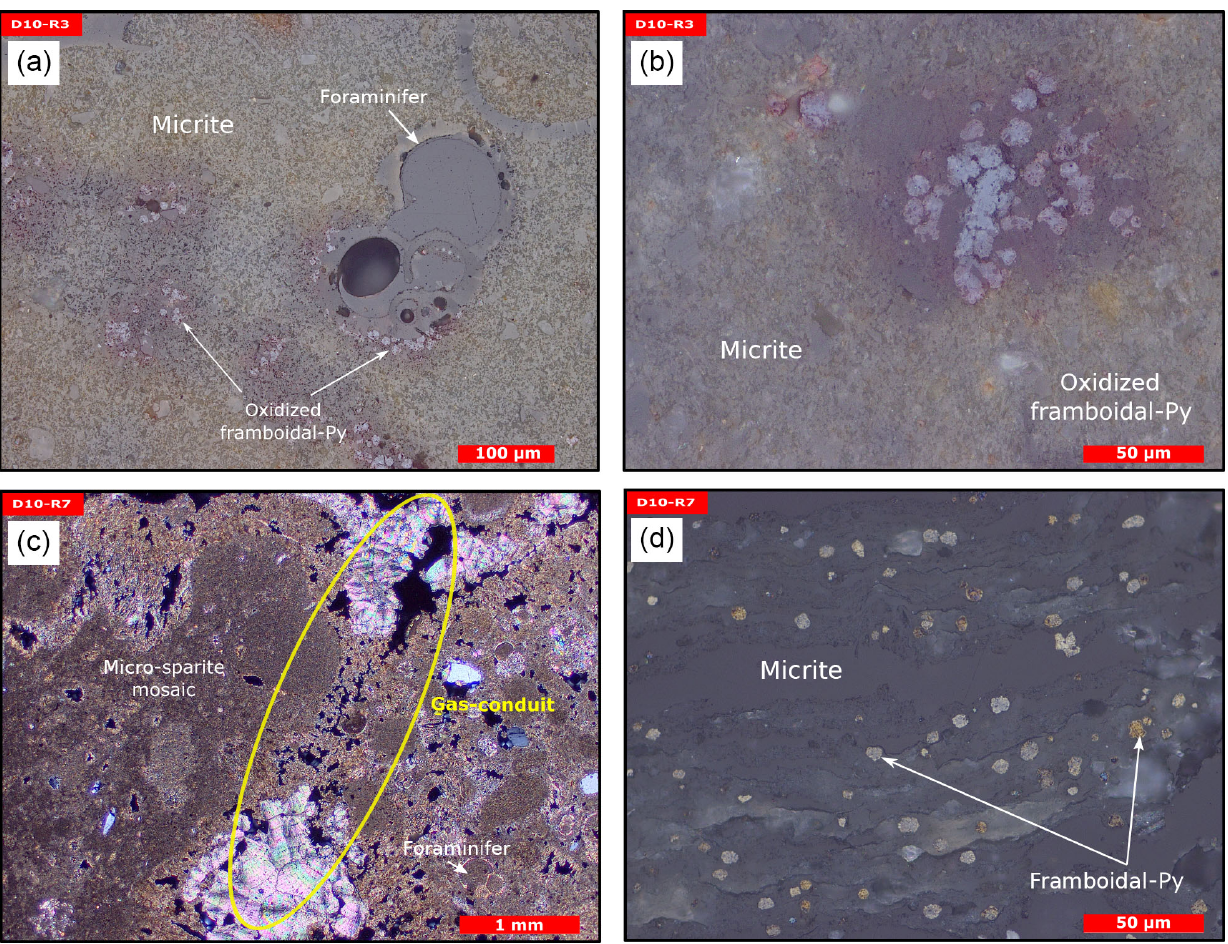
Figure 8. Thin section photographs of MDACs. (a–b) D10-R3 consisting of a micritic matrix with scattered foraminifers and oxidized framboidal pyrites (reflected light). (c–d) D10-R7 consisting of micritic and micro-sparitic carbonate with abundant unaltered framboidal pyrites ( c transmitted light and d reflected light). Please note the open voids that represent potential pathways for fluid seepage (yellow circle in c ).